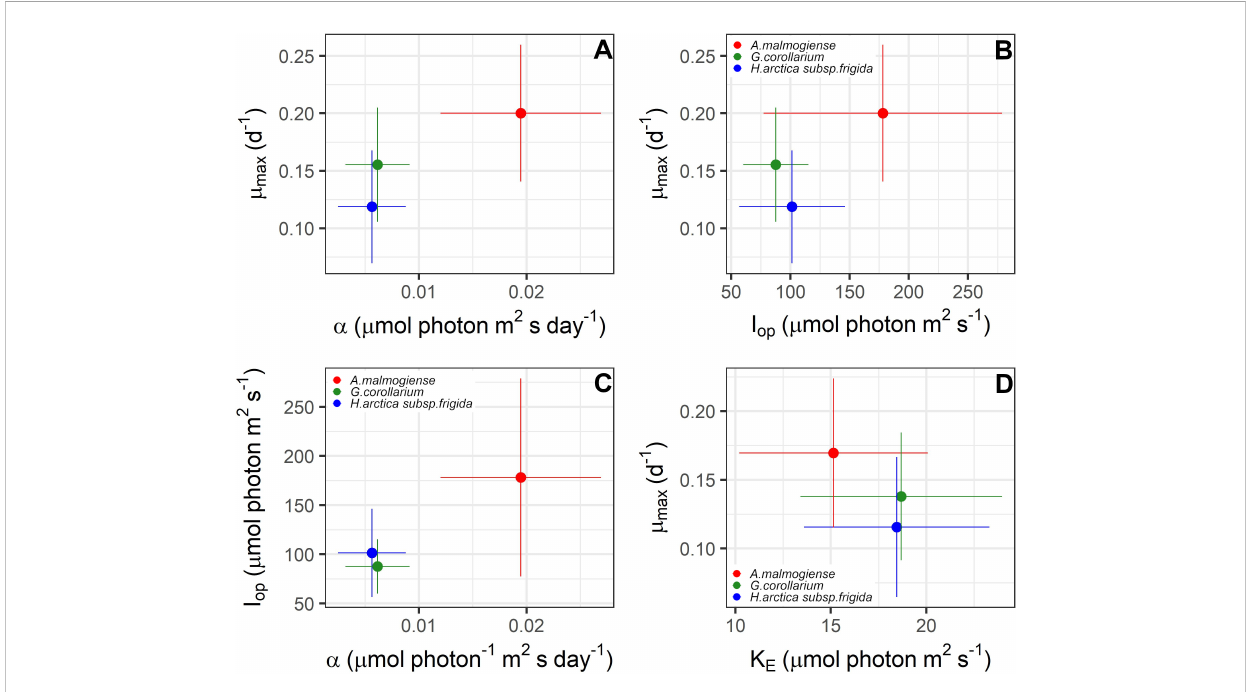
FIGURE 8 Relationships between photo-physiological traits estimated for Apocalathium malmogiense , Gymnodinium corollarium , and Heterocapsa arctica subsp. frigida . The points depict the averages and the bars the standard deviations found in all the experiments. (A – C) are the parameters estimated using Eilers & Peeters (1988) 3-parameter model; (D) depicts relationship between the two-parameter estimated with MacIntyre et al. (2002)